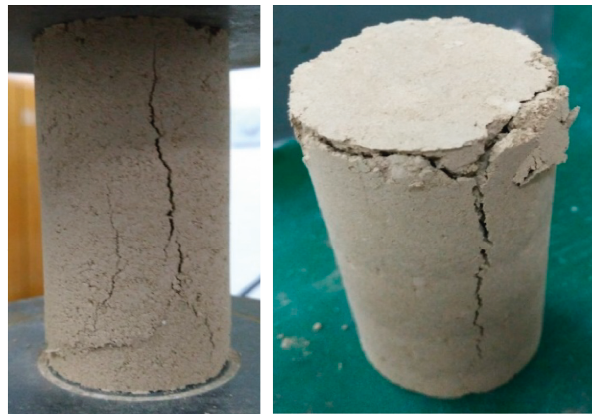
Figure 2: Unconfined compression